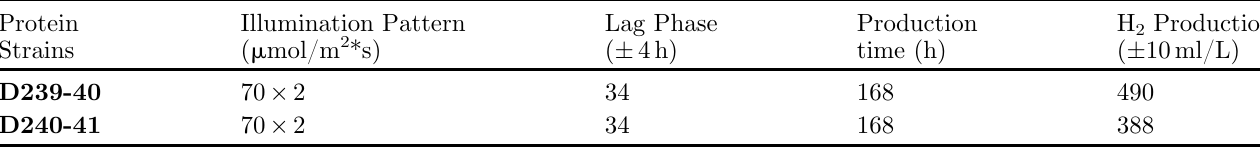
production by mutant strains of C. reinhardtii [27]. 2